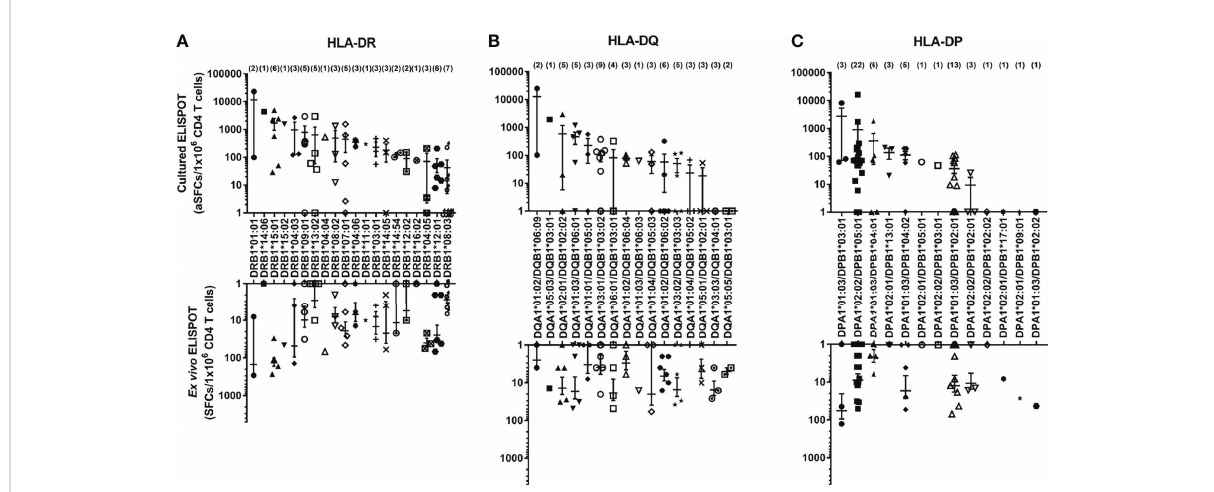
FIGURE 3 The frequencies of antigen-speci fi c CD4 + T cells by allotypes. The frequencies of M. tuberculosis antigen-speci fi c CD4 + T cells by HLA-DR (A) , -DQ (B) , and -DP (C) allotypes measured by ex vivo and cultured ELISPOT. The parentheses indicate the number of donors with the allotype. Error bars present mean ± standard error of the mean.